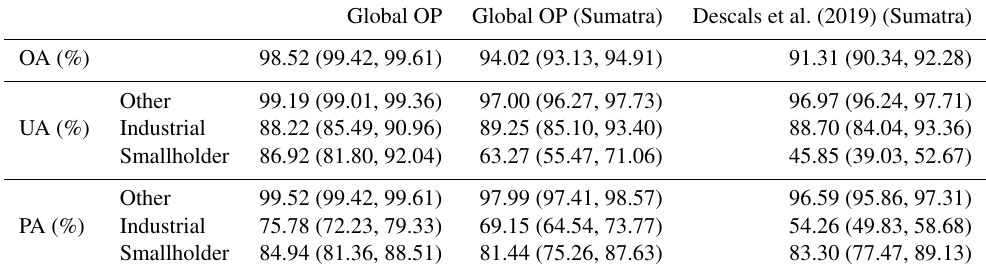
Figure 3. Examples of industrial and smallholder oil palm plantations seen by a 10m resolution Sentinel-1 and Sentinel-2 composite (red channel: VV; green channel: VH; and blue channel: Band 4). The VV and VH bands were transformed and stretched so that the closed- canopy oil palm appears in green. (a) An industrial plantation on a flat surface in Brazil with harvesting trails built in straight lines and thus forming rectilinear grids. (b) An industrial plantation on hilly terrain in Indonesia, with curvy harvesting trails. (c) Smallholder plantations forming a large homogeneous cluster in Indonesia. (d) Smallholder plantations of varying shape, size, and tree age in Côte d’Ivoire (image source: Copernicus Sentinel data 2019). Table 2. Accuracy assessment of the global oil palm layer for the second half of 2019 and comparison of the global layer with the results of a previous study (Descals et al., 2019) which used a random forest in Sumatra for the same year. The accuracy metrics of the global layer were estimated with 10816 points randomly distributed in the main oil-palm-producing areas in the world, while the comparison used only the validation points that were located in Sumatra (2463 points). The reported metrics are the overall accuracy (OA), the user’s accuracy (UA), and the producer’s accuracy (PA). The accuracy metrics are reported with a confidence interval (95% confidence level). Global OP Global OP (Sumatra) Descals et al. (2019)